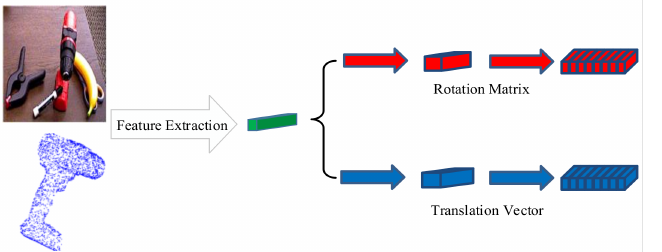
Figure 6. Feature fusion in the refine model. The fine-tuning network takes the result of the last iteration as the input point cloud, and the main network is mostly the same as the previous matching